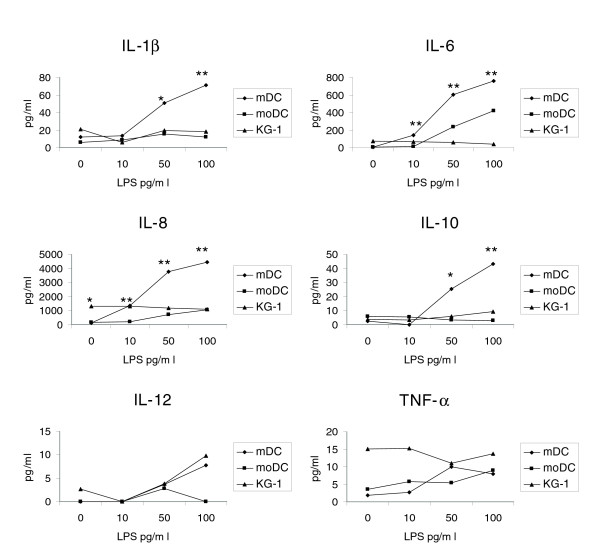
Cytokine expression profiles of cells. Cytokine production by mDCs and the DC models in response to LPS. Cytokine concentrations were measured by CBA and analyzed using the cytometric CBA analysis software; with further analysis in Excel. Data shown are the means of triplicate experiments. A Student t-test was carried out to determine the significance of the data (*p < 0.05, **p < 0.01).